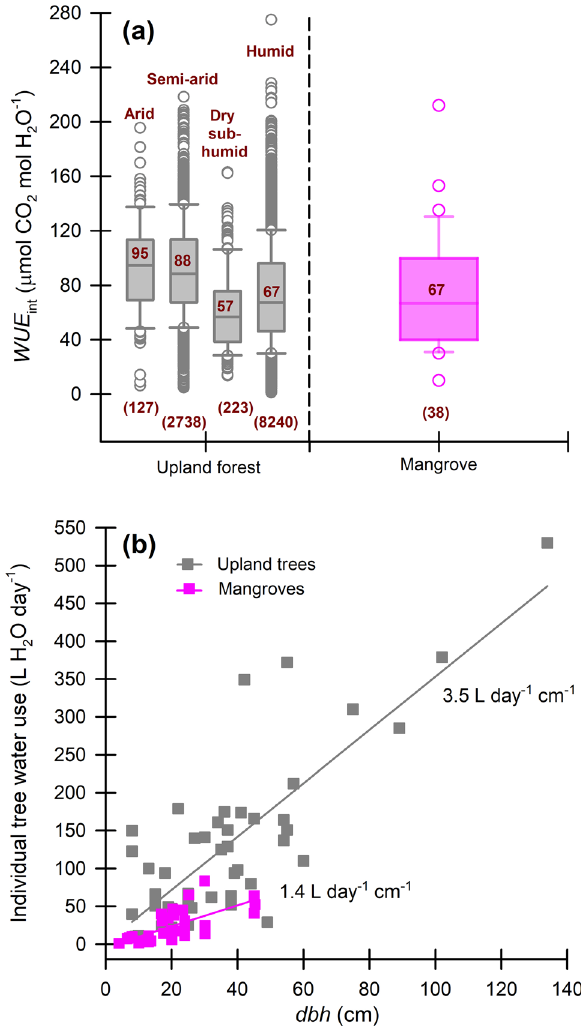
Figure 1. Leaf-intrinsic water use efficiency ( WUE int ) and individual tree water use for mangroves versus terrestrial woody vegetation. ( a ) WUE int for a mix of seedlings, saplings, and trees of upland species from arid, semi-arid, dry semi-arid, and humid environments 60 versus mangrove, depicting median (center line and values), upper and lower quartiles (box limits), 1.5 × interquartile ranges (whiskers), and outliers (points) as box-and-whisker plots, and sample sizes depicted within parentheses. ( b ) Individual tree water use